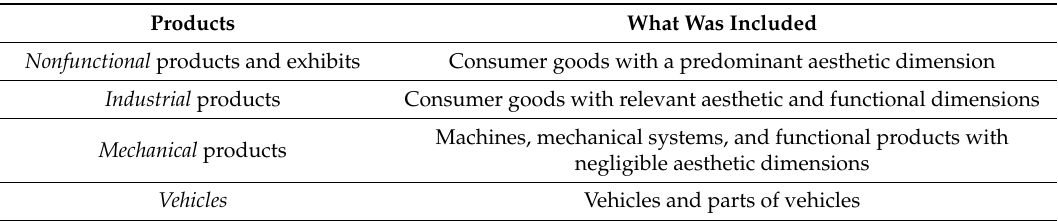
Table 5. Categories of designed